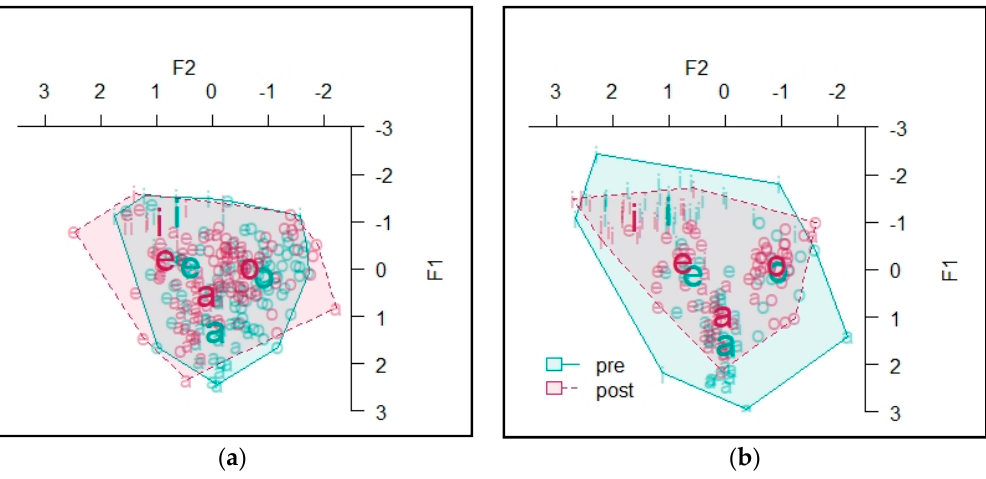
Figure 11. Informant E vowel spaces from pre-semester and post-semester measurements: ( a ) vowels from unstressed syllables; ( b ) vowels from stressed syllables.